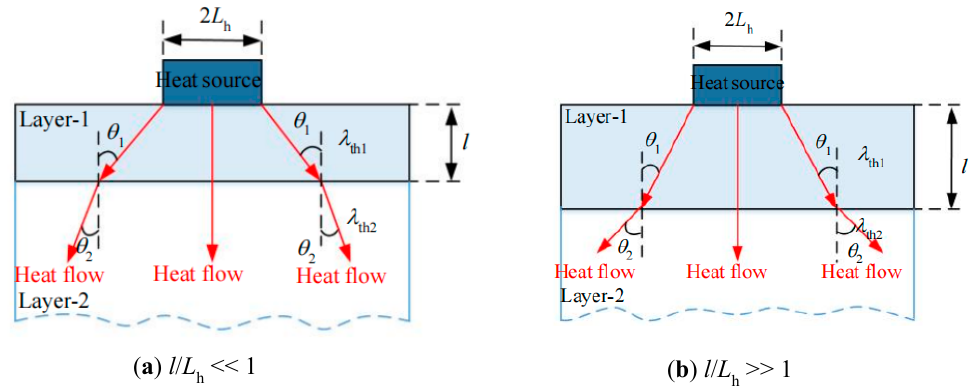
Figure 10. Effects of the vertical boundary on the thermal spreading angle.